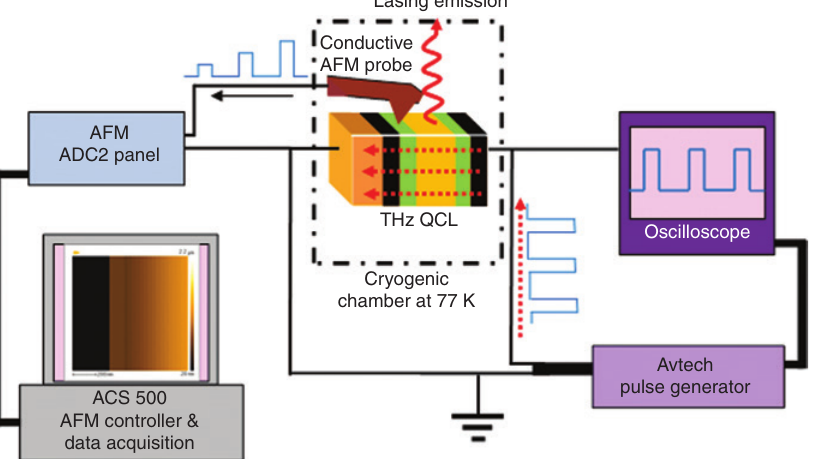
Figure 1: Experimental details. The SVM setup is as follows: the device under test is mounted to a cold finger, and the cold finger is mounted to the piezoelectric stage of the cryogenic atomic force microscope (Attocube, ACS 500). The AFM microscope head is sealed in a vacuum tube (vacuumed and filled with low-pressure helium gas) and submerged into a chamber that is filled with liquid nitrogen. The cleaved laser facet (uncoated) is placed upward, on which the AFM conductive probe scans in contact mode. The device is biased in pulsed mode using an Avtech pulse generator, with a pulse width of 3.5 μ m and repetition rate of 100 Hz. The voltage signal picked up by the AFM probe is fed directly into the AFM data acquisition system through a built-in ADC panel 2. The high impedance of the ADC panel minimizes the perturbation to device operation due to the physical contact of the AFM probe across device active region. The noise floor in voltage measurement is ~ 0.1 mV. In the SVM experiments, the scan range is set to 11 × 11 μ m 2 (for rough scans) or 512 × 512 nm 2 (for high-resolution scans). The scan speed is set accordingly to synchronize the SVM voltage reading at each sampling point with the device bias